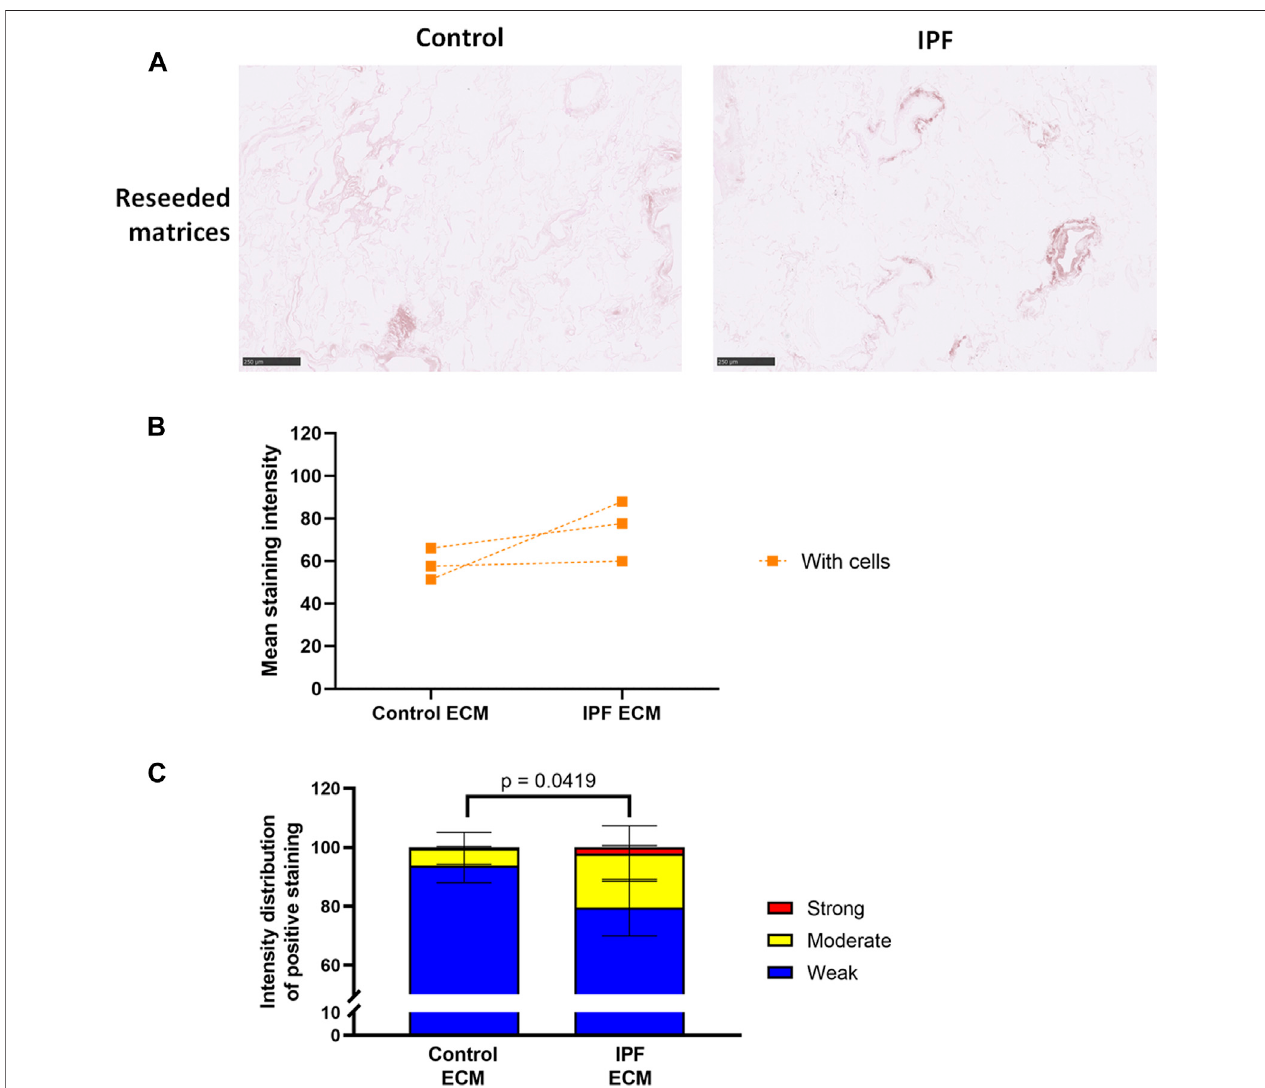
FIGURE 4 | Equal levels of denatured collagen in recellularized control and IPF matrices. Primary lung fi broblasts were seeded into decellularized matrices and cultured for 7 days. Sections of recellularized lung tissue were stained using collagen hybridizing peptide (B-CHP, brown) and an eosin counterstain (pink). (A) Representative images of the B-CHP stained recellularized matrices, showing a magni fi ed part of the image of the total tissue section. Scale bar (cid:2) 250 µm. (B) Quanti fi cation of the B-CHP staining, showing the mean staining intensity. Groups were compared using an unpaired t test after assessing the normal distribution with use ofa QQ plot and a Shapiro-Wilk normality test ( Supplementary Figure 2A ). No signi fi cant differences were observed ( p > 0.05). (C) Quanti fi cation oftheintensitydistributionoftheB-CHPstaining.Groupswerecomparedusingatwo-wayANOVAfollowedbytheoriginalFDRmethodofBenjaminiandHochbergpost hoc test. p > 0.05 was considered signi fi cant. All matrices are derived from the same control and IPF donor, primary lung fi broblasts were obtained from three different control donors ( n (cid:2) 3, dots connected per n